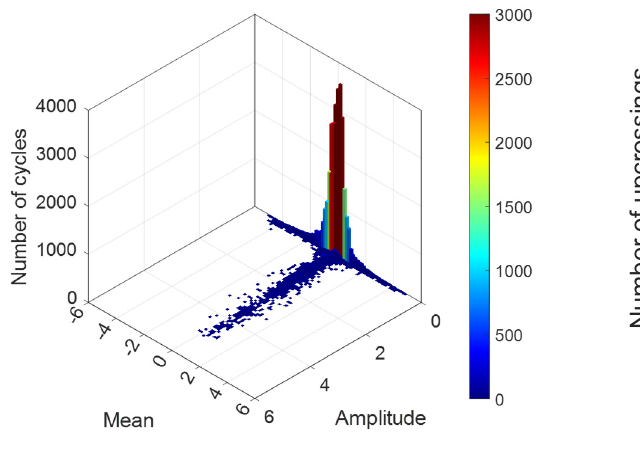
Figure 13. Short-time Fourier transform and run test applied to CH4 time history (inner rim), shown at the bottom of the figure. In both methods, the window time length was 10 s. Once the individual CH4 time history was divided into three states, and then into blocks, the confidence interval of damage was computed as a function of the number of